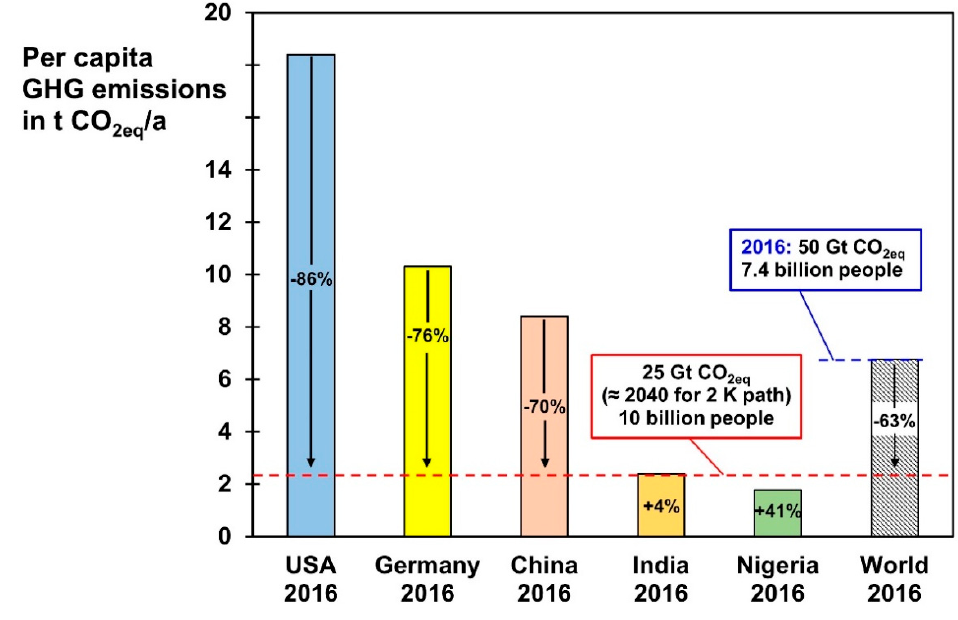
Figure 10. Annual per capita GHG emissions (incl. LUC) in selected countries and in the world 2016 and in case of reduction of GHG emissions by 50% for a population of 10 billion.